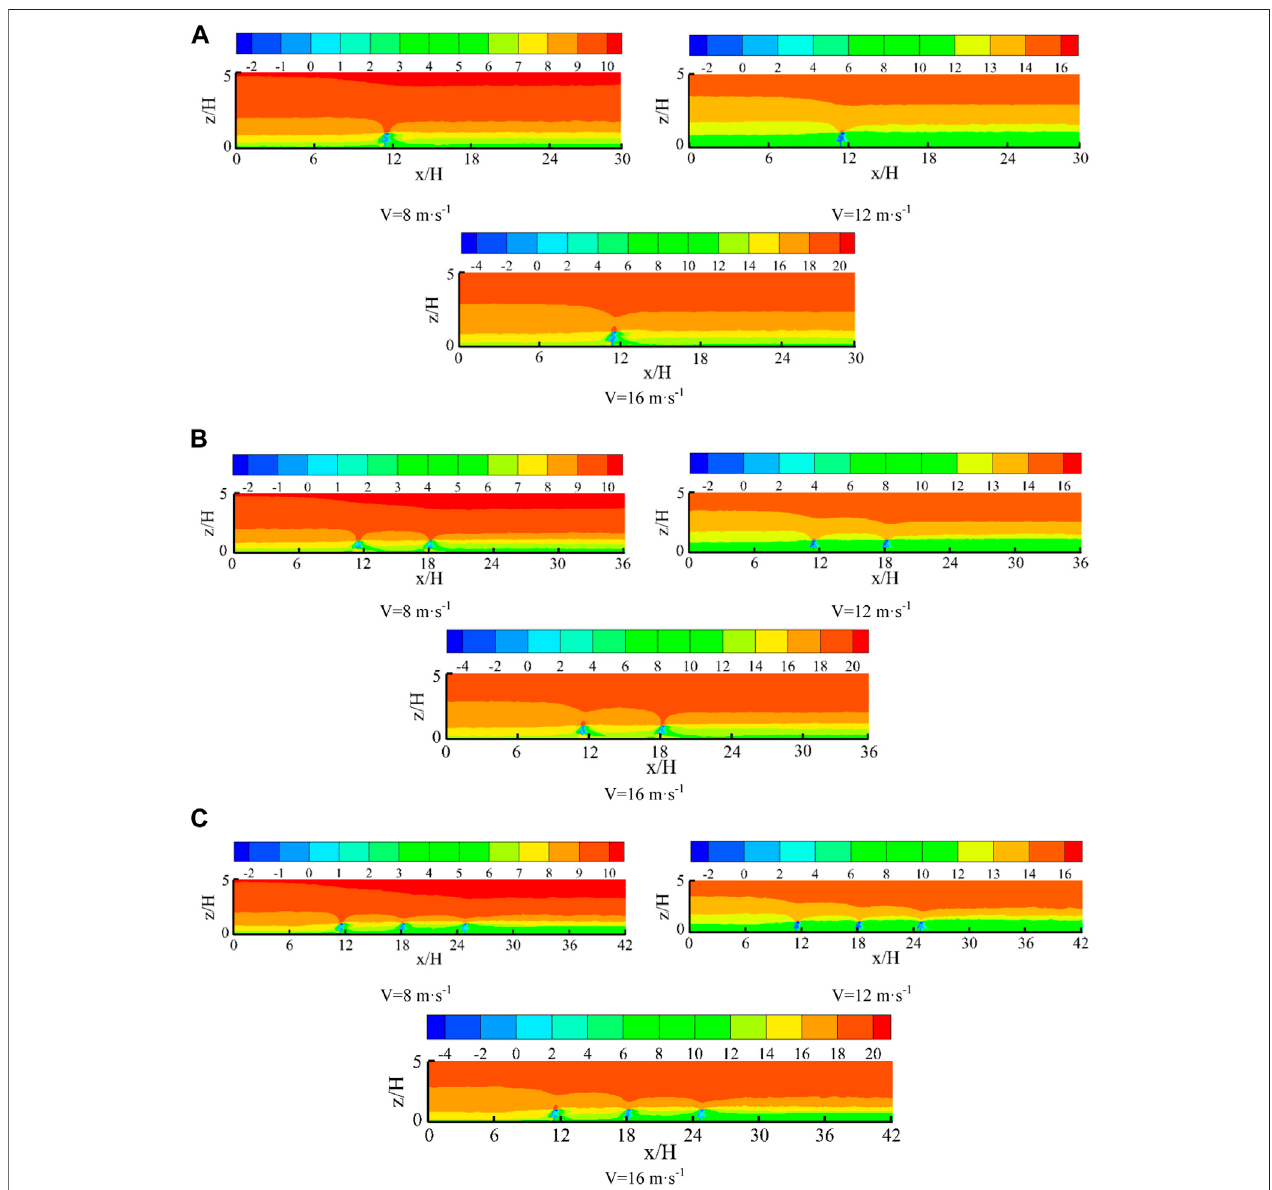
FIGURE 5 | Distribution characteristics of fl ow fi eld near forest belts. (A) : Single row of forest belts, (B) : Two rows of forest belts, (C) : Three rows of forest belts.